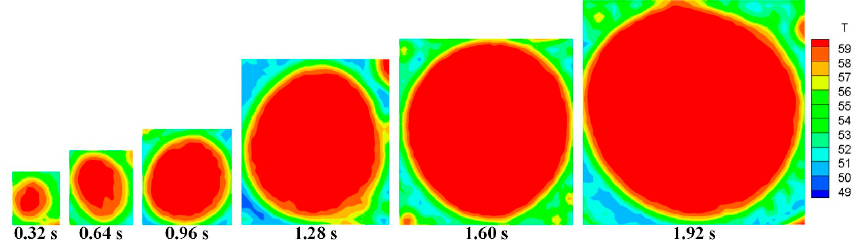
Figure 5. Front view of the temperature distribution of a typical single droplet surface at different times.